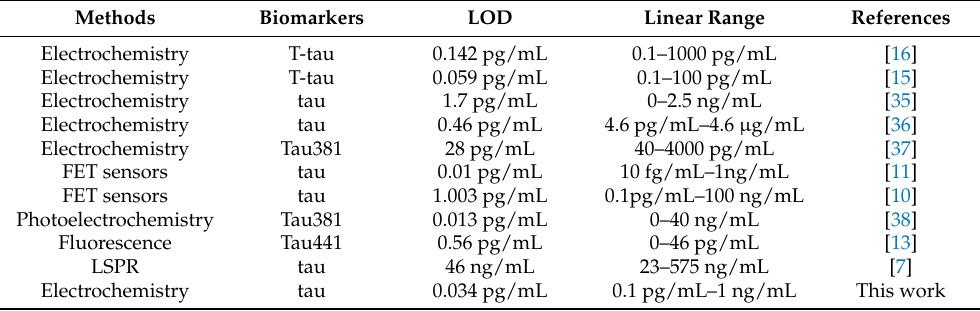
Table 1. A comparison between this electrochemical aptasensor and other methods for the detection of tau protein.